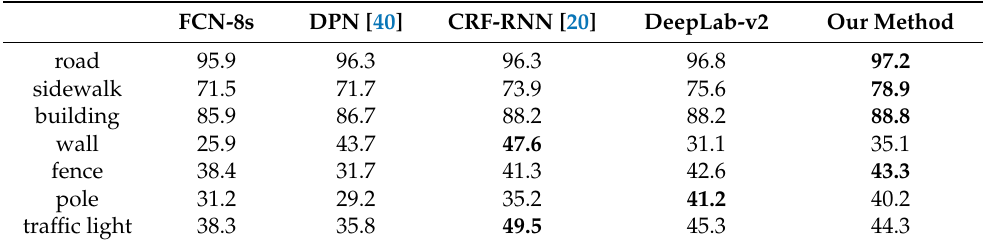
Table 3. Per-class IoU score on Cityscapes dataset. Best performance of each category is highlighted in bold.